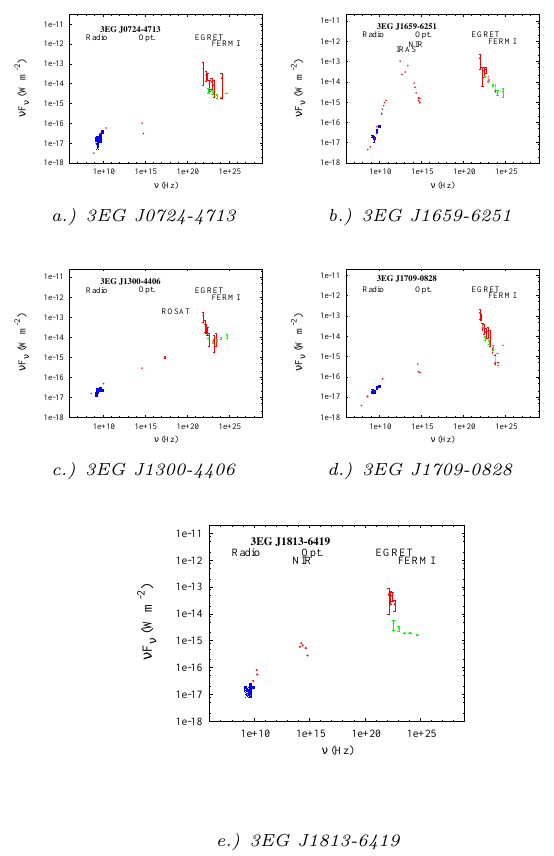
Figure 7: The multifrequency SEDs for the sample of EGRET